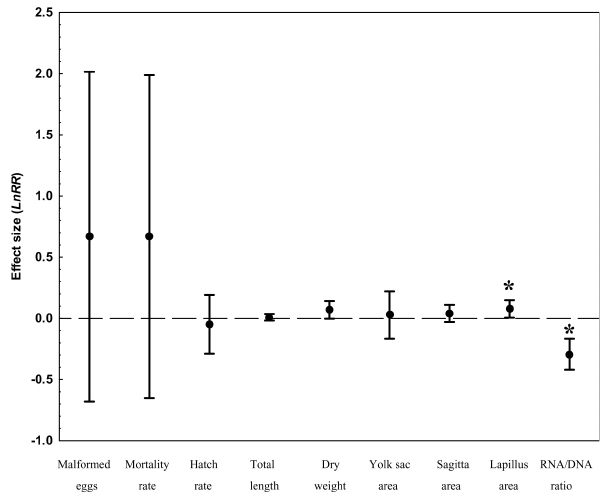
Fig. 6. Effect sizes and 95% confidence intervals for all examined variables (embryonic malformations, mortality rate of eggs, hatch rate and total length, dry weight, yolk sac area, sagitta area, lapil- lus area and RNA/DNA ratio of newly hatched Atlantic herring lar- vae) based on the differences between control ( p CO 2 480µatm) and highest treatment ( p CO 2 4635µatm). The effect size is significant when the 95% confidence interval does not overlap with zero